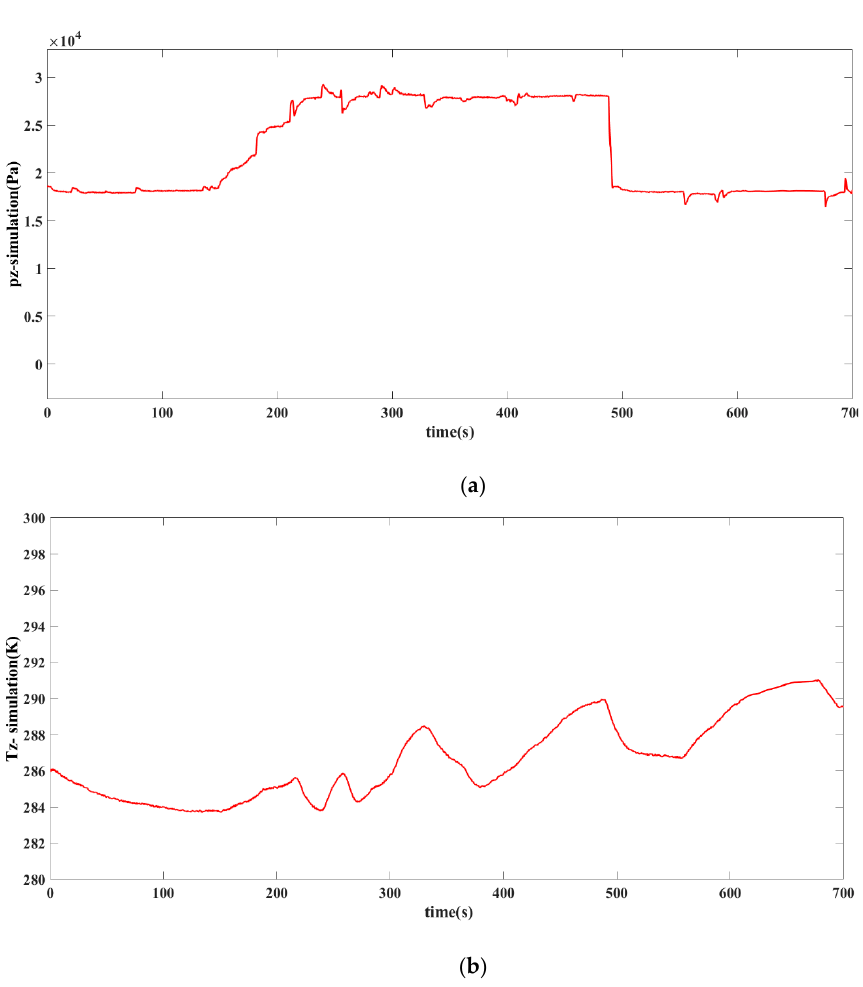
Figure 7. The simulation results of the suction pipeline. ( a ) The simulation results of the pressure, ( b ) the simulation results of the temperature.